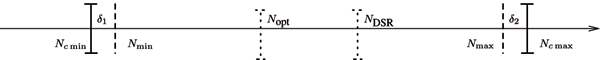
The relative positions of the different counts on the real line. See text for details.